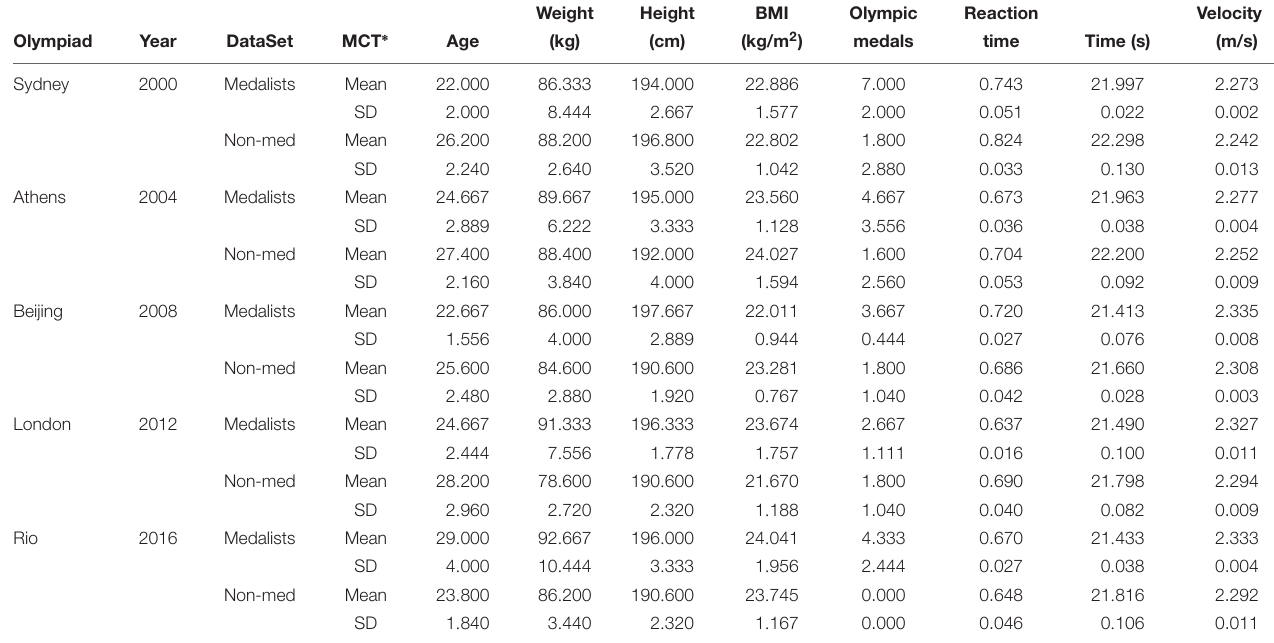
TABLE 1 | Measures of central tendency – mean and standard deviation – by each Olympic edition split by medalists and non-medalists athletes. Weight Height BMI Olympic Reaction